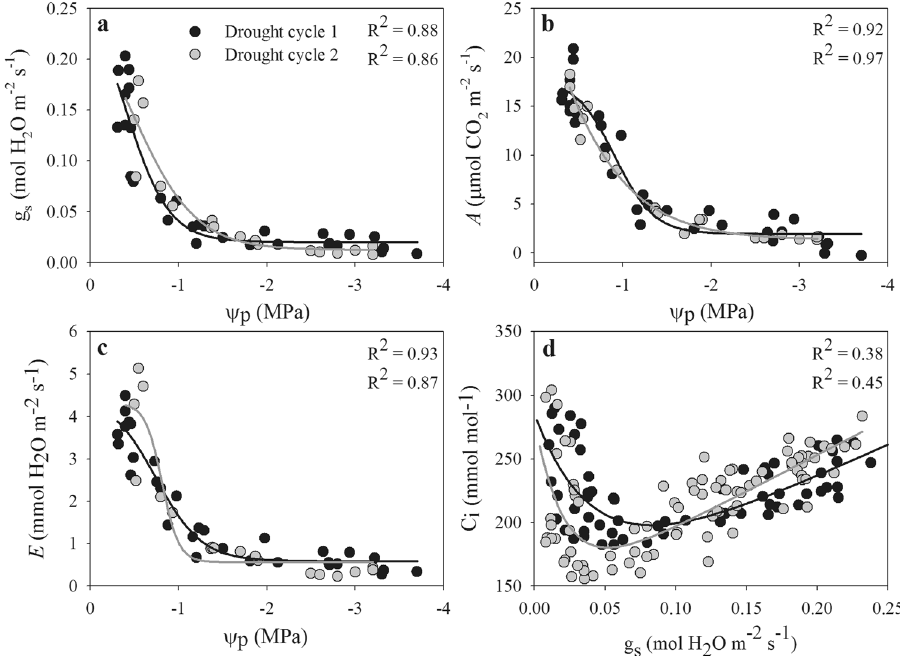
Figure 2. Relationships of measured g s , A and E with Ψ p and of intracellular CO 2 concentration (Ci) with g s in A. fruticosa of drought plants during drought cycles 1 (black circles) and 2 (grey circles).